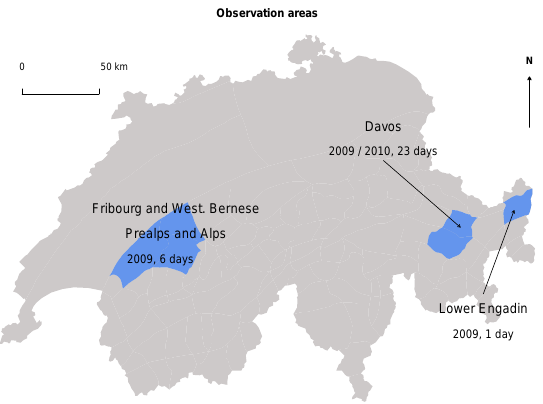
Fig. 3. Map showing Switzerland (grey) and the regions (blue), where measurements were conducted in 2009 and 2010. The num- ber of days is shown, when measurements were carried out. The majority of measurements were taken in the region surrounding Davos.